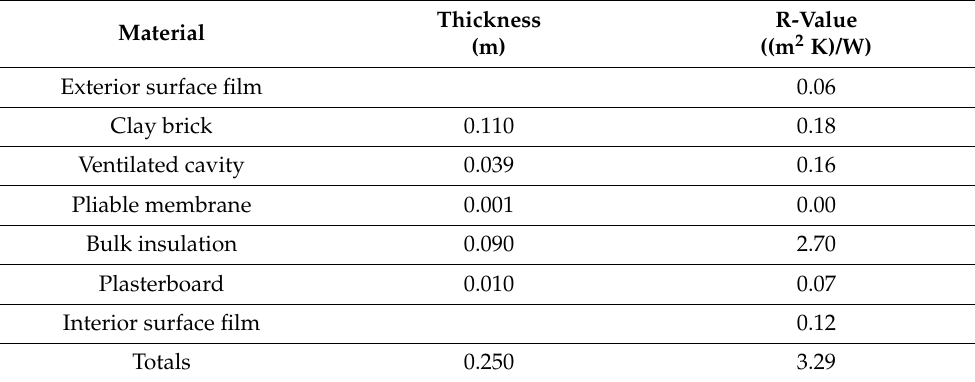
Table 3. Summary of calculation of R-value for the wall